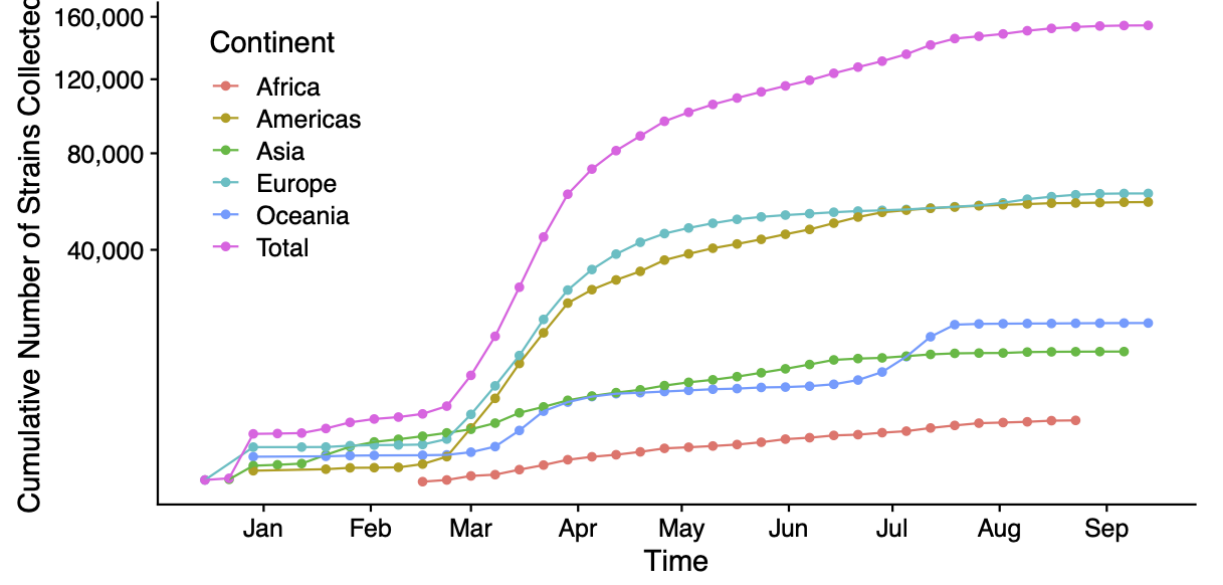
Figure 1. The cumulative number of sequences hosted by public databases has increased over time. Sequences from Asia increased steadily since January, whereas sequences from other continents saw a dramatic increase in March. Each data point represents a week. Note that the x-axis shows collection dates, which can precede submission dates by several weeks (eg, a sequence collected in July may be submitted in August). Therefore, lines that do not reach August indicate that sequences recently collected have not been submitted yet.